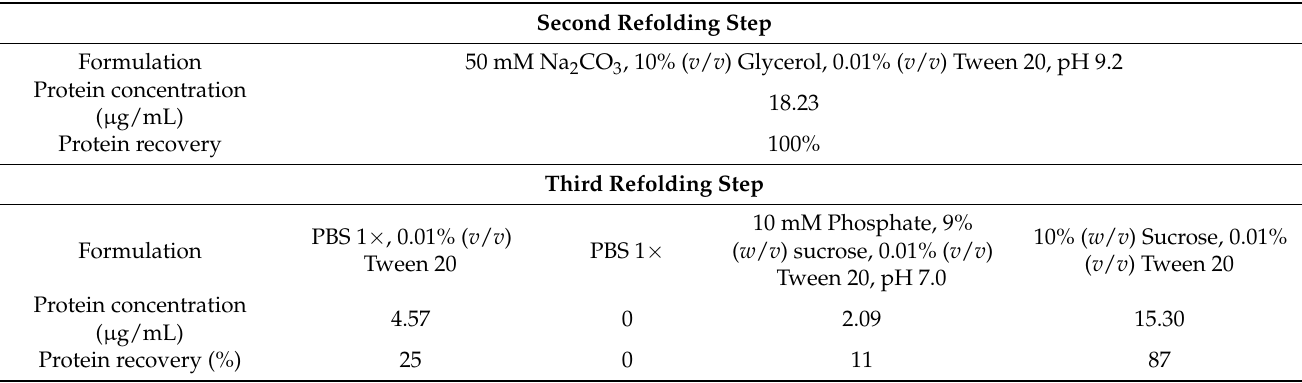
Table 1. Protein concentration after a third step of refolding buffer. Second Refolding